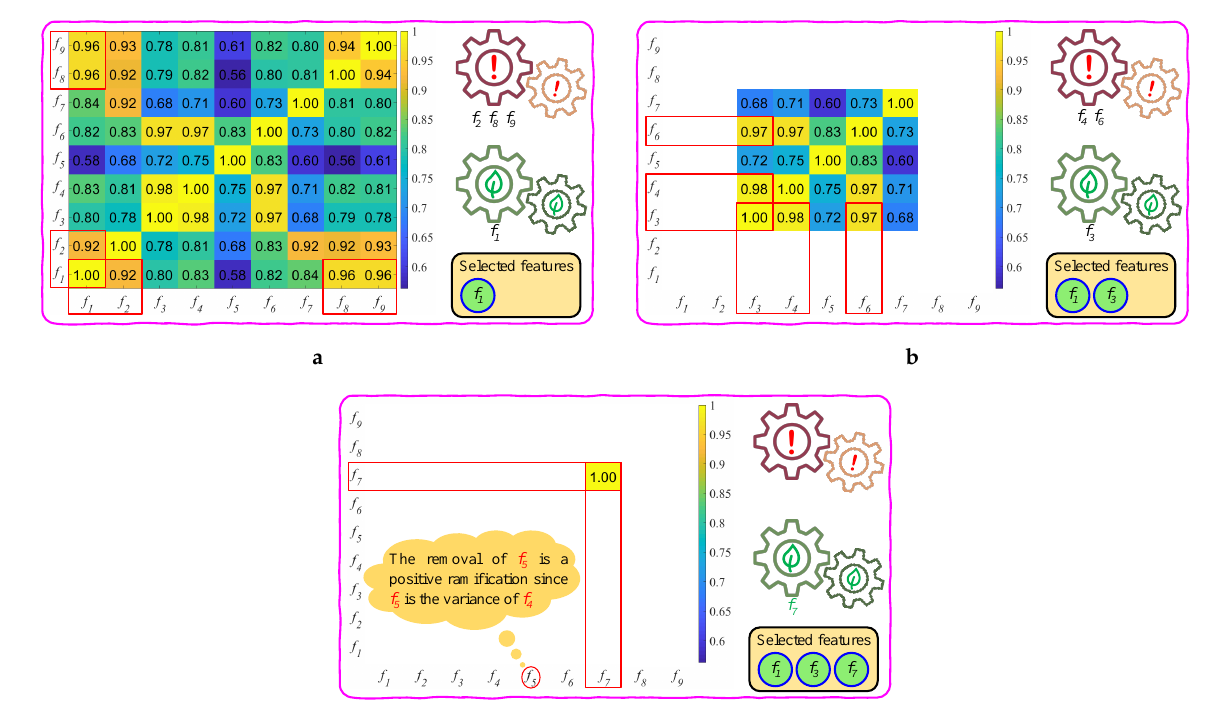
Figure 6. Illustration of the correlation and computation analysis for feature selection: ( a ) the first round, ( b ) the second round, and ( c ) the third